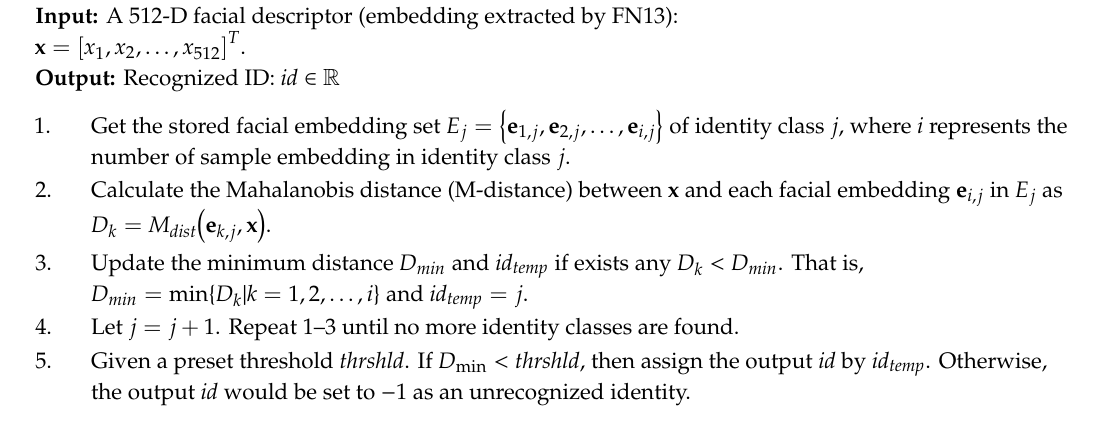
Algorithm 1. Embedding Matching with Multiple